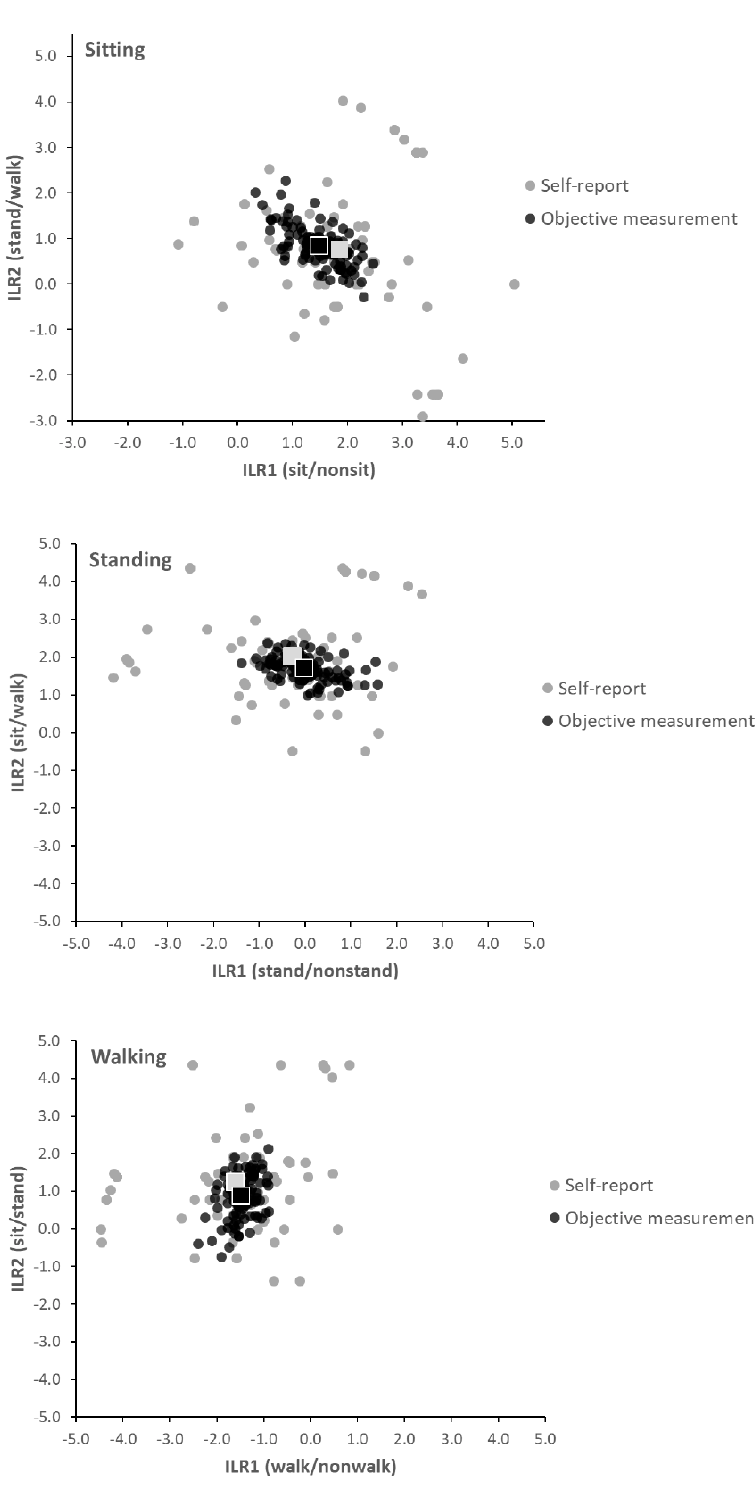
Figure 1. Distribution in the population ( n = 98) of self-reported (grey circles) and objectively measured (black circles) physical behaviors (sit, stand, walk), expressed in terms of two isometric log-ratios (ILR1 and ILR2). The first ILR ( x -axis) expresses time spent in one behavior, as stated in the upper left corner of each diagram, relative to time in the two remaining behaviors (e.g., sit / nonsit), and the second ILR ( y -axis) expresses the relative time spent in each of these two behaviors (e.g., stand / walk when sit / nonsit is the first ILR). Squares show group means for self-report (grey) and objective measurement (black).